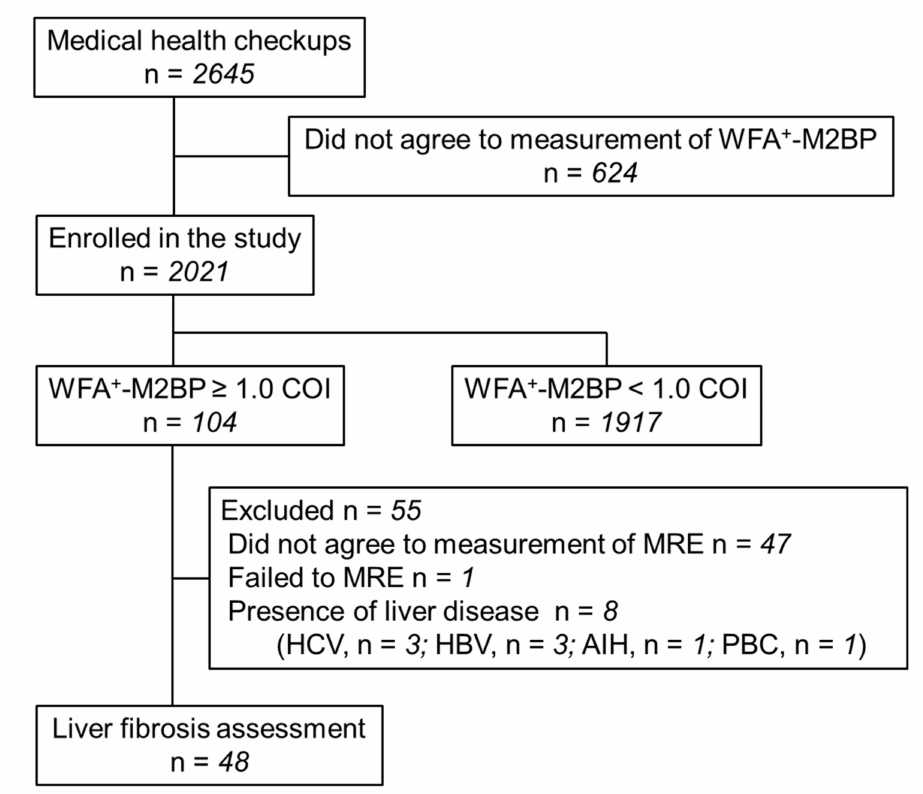
Figure 1. The study flow